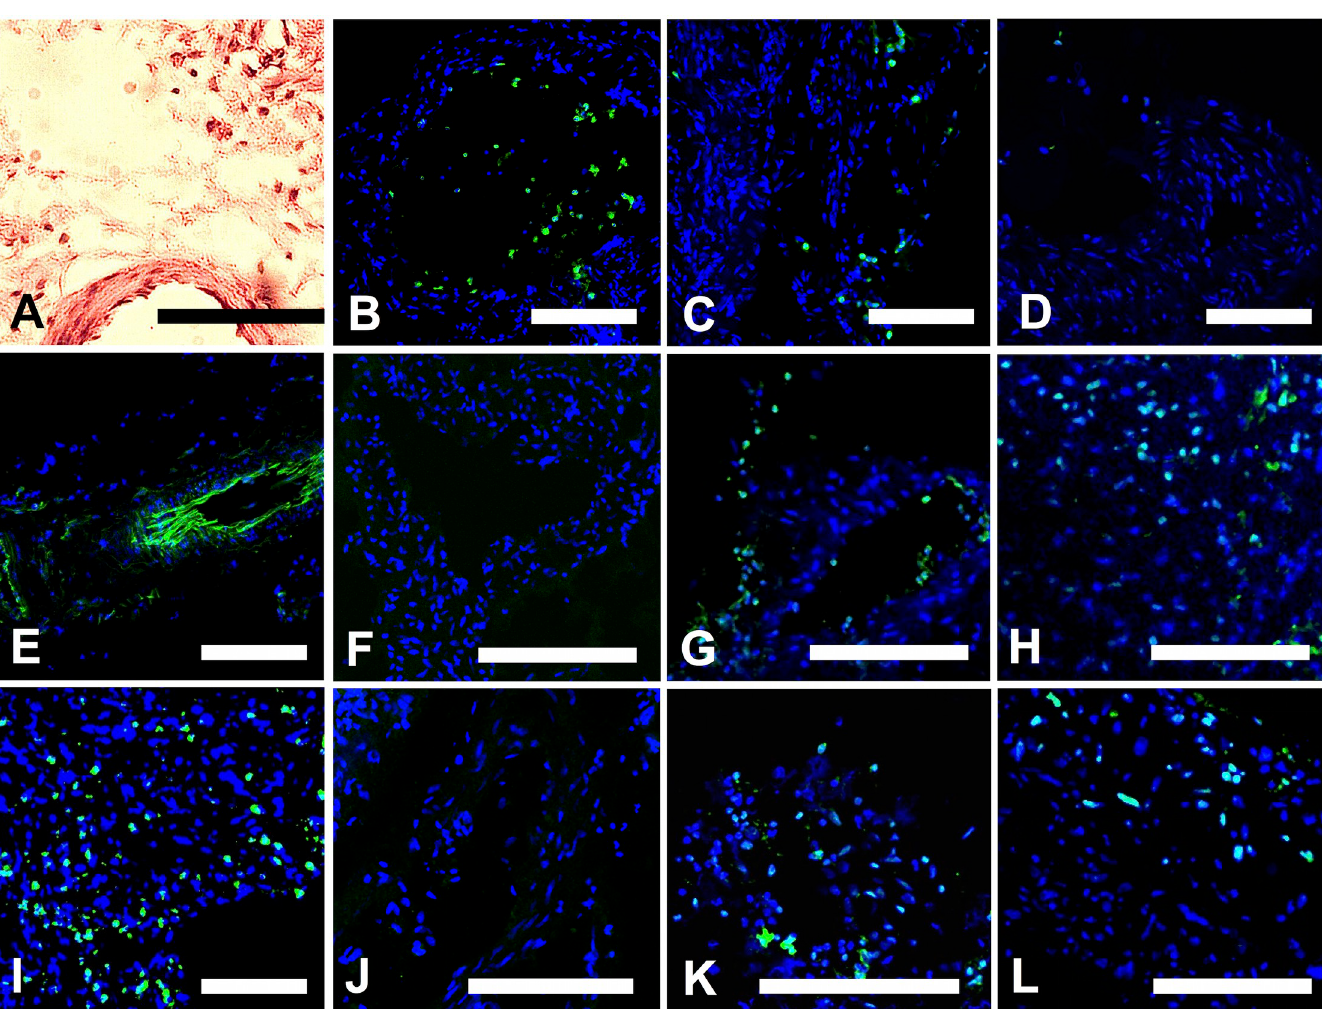
Fig 2. Lymphatic vessel imaging. A. H & E stained sections of the LVs, show that the nuclei were sufficiently preserved for subsequent Paired-Box-Gene 8 (Pax-8) and WT1 (Wilms-Tumour-1) staining. B-D. LVs with high, medium and low/no inflammatory state determined with myeloperoxidase (MPO) staining. E. Confirmation of LV status was carried out using LEC marker Podoplanin (PDPN) that stained around the LV lumen. F-H. Imaging with WT1, (F) negative LV, (G) positive LV (H) positive control. I. Tumour MPO positive control. J-L. Imaging with Pax-8, (J) negative LV, (K) positive LV and (L) positive control. An Ovarian tumour sample was used as a positive control and stained for both (M) WT1 and (Q) Pax-8. Scale = 140 μ